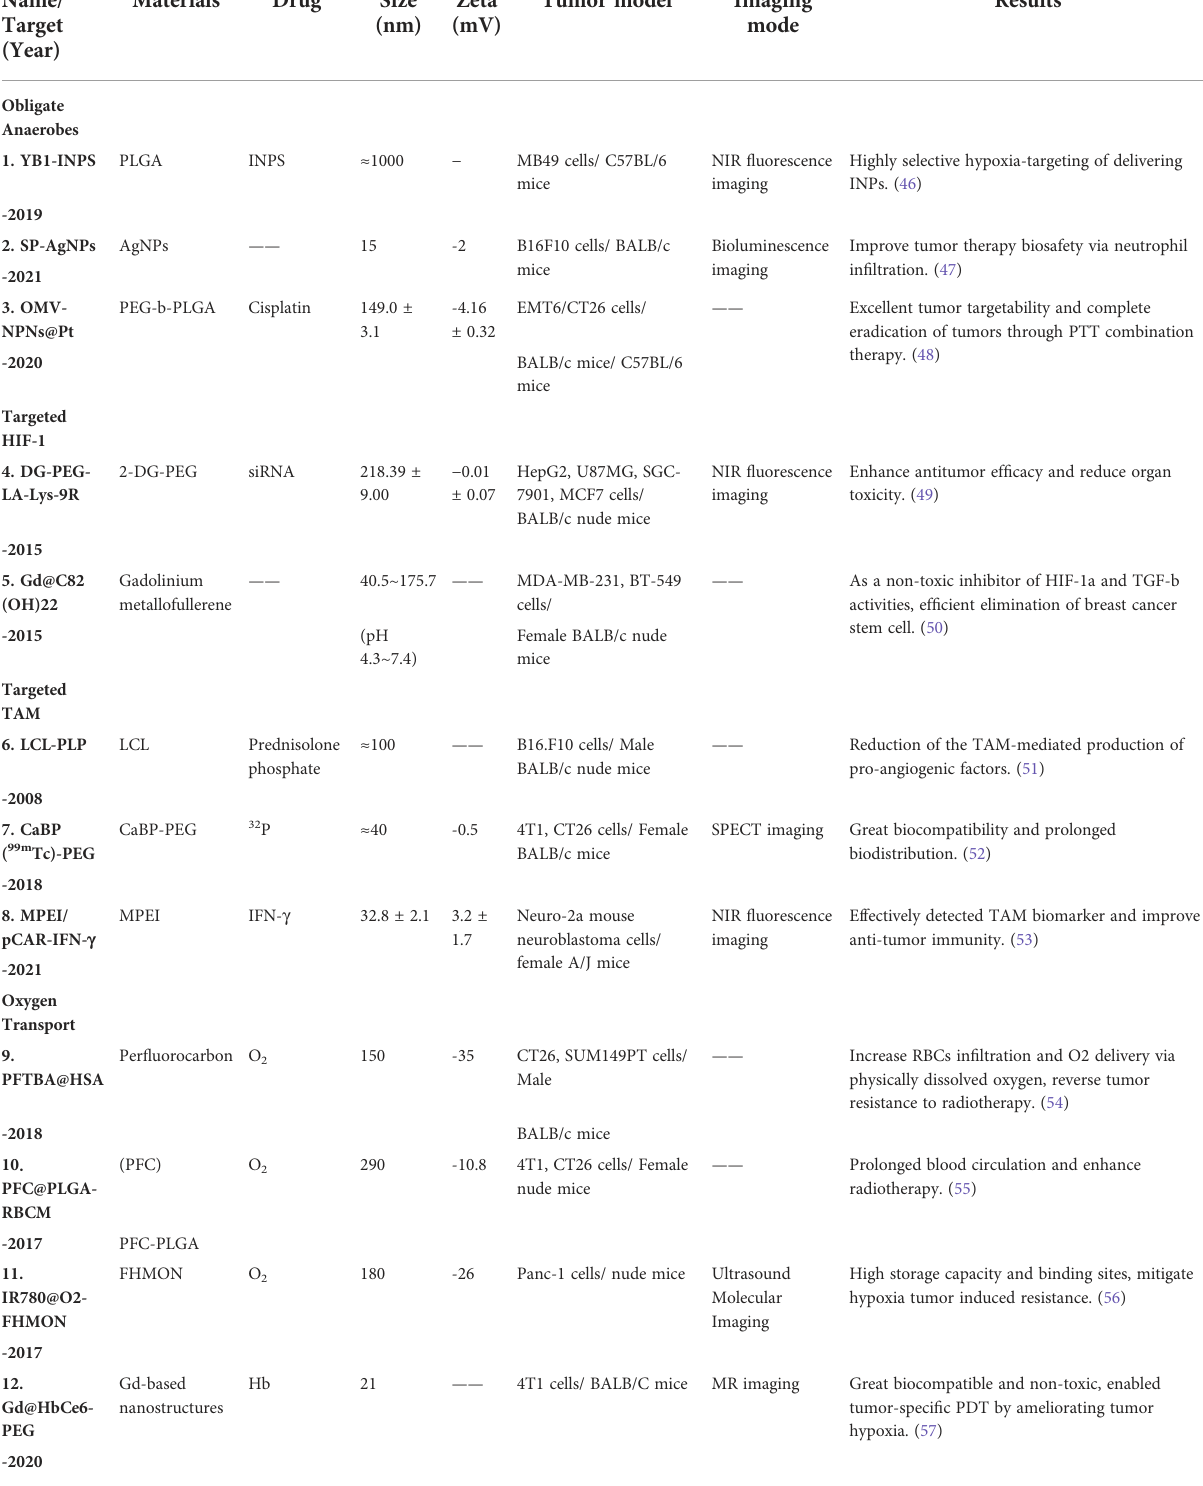
TABLE 1 Active targeting nanomaterials and nanoparticles for oxygen